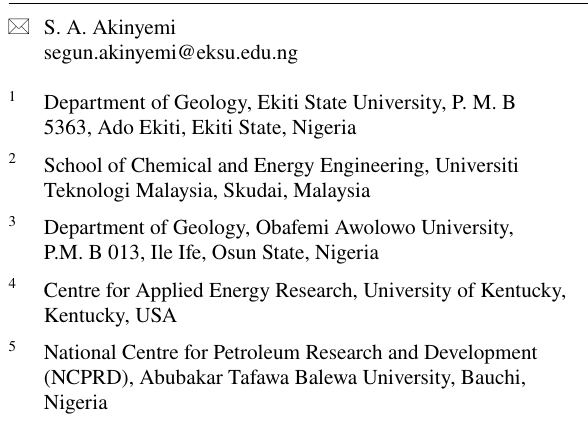
Table 1: Proximate analyses (as-received basis) and ulti- mate analyses (dry basis; C, H, N, total S, and O by differ- ence). The derived values (O/C, H/C and VM/FC), heating value parameters (HHV and LHV) and mineral matter (MM) of coals. Table 2: Macerals, subtotals of vitrinite submacerals (in italics), and totals of maceral groups and of minerals (in italics) along with the vitrinite maximum and random reflec- tances and the respective standard deviations of the reflec- tances. Note that the first column for each coal includes